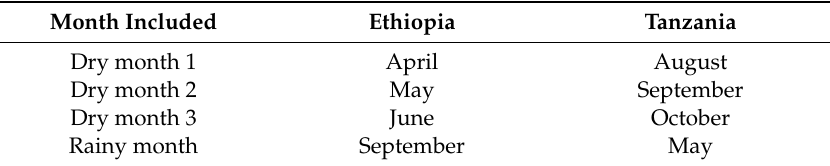
Table 2. Included months in the integrated models.